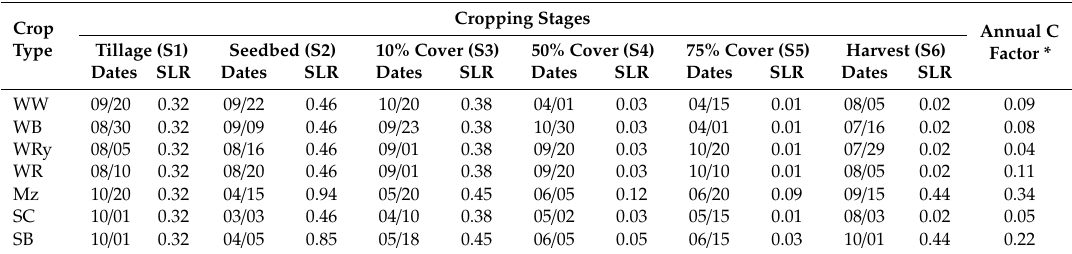
Table 1. Di ff erent cropping stages of the considered crops along with their measured Soil Loss Ratio (SLR) value used in the